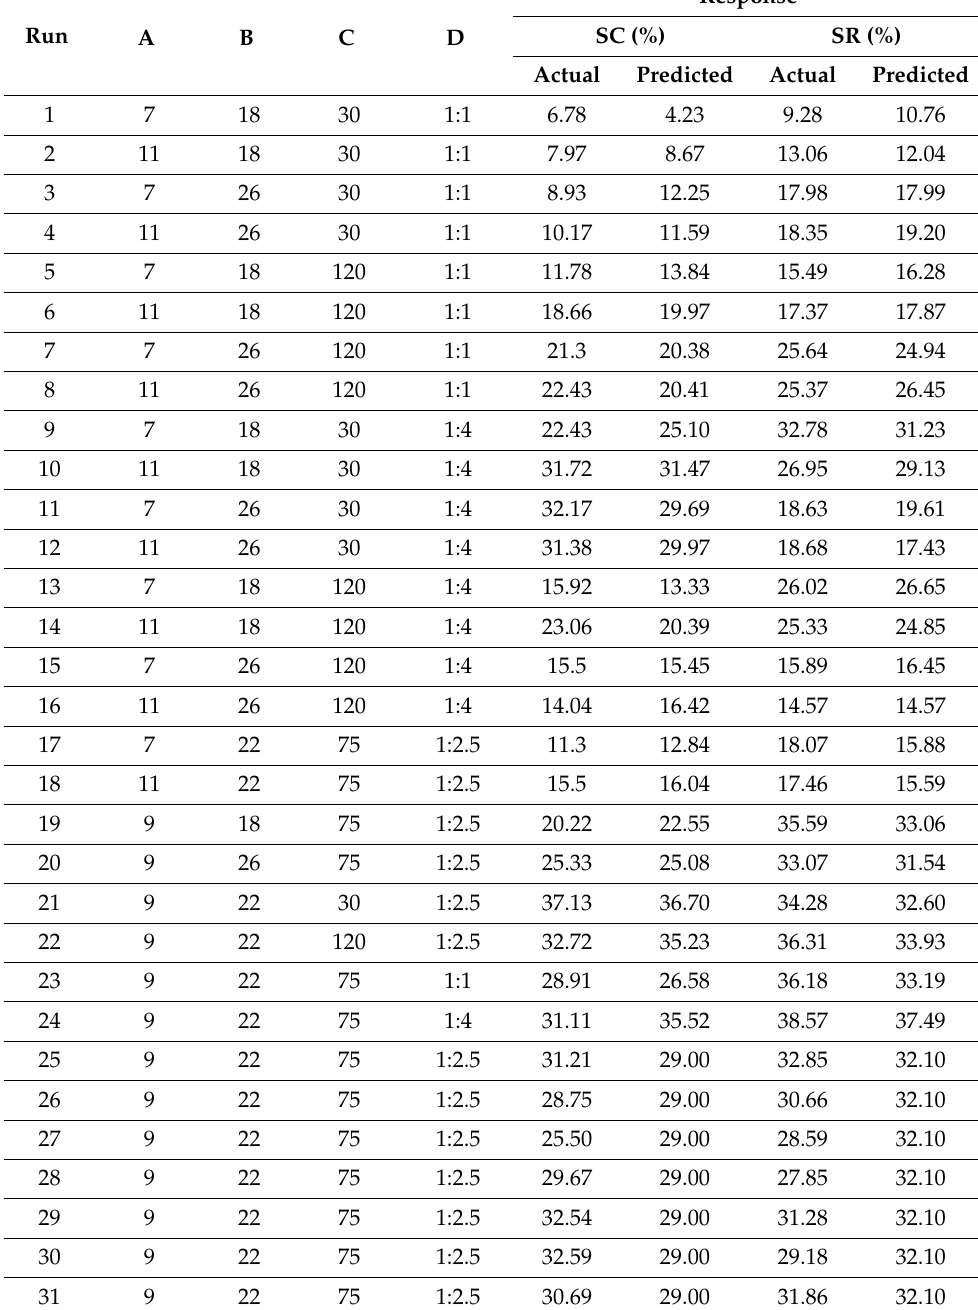
Table 3. Central composite design of experiments for in situ silica sol-gel synthesis on oil palm